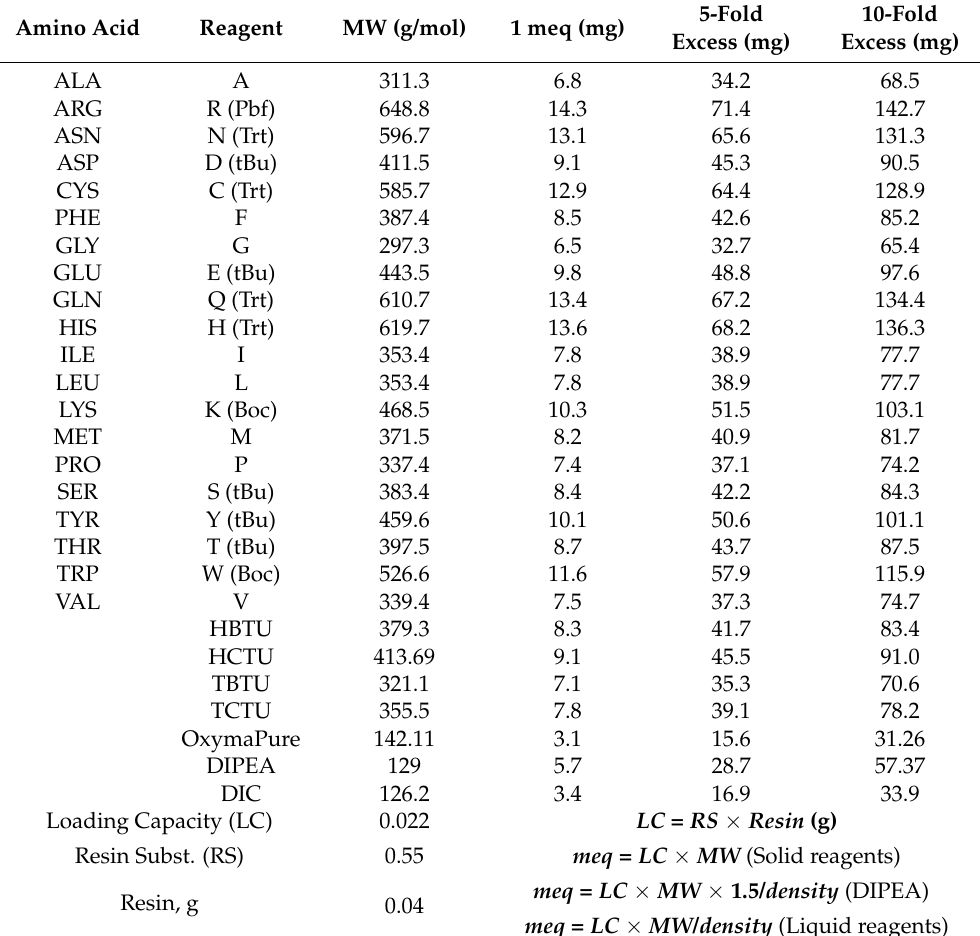
Table 1. Spreadsheet to calculate the quantities for reagents’ stock